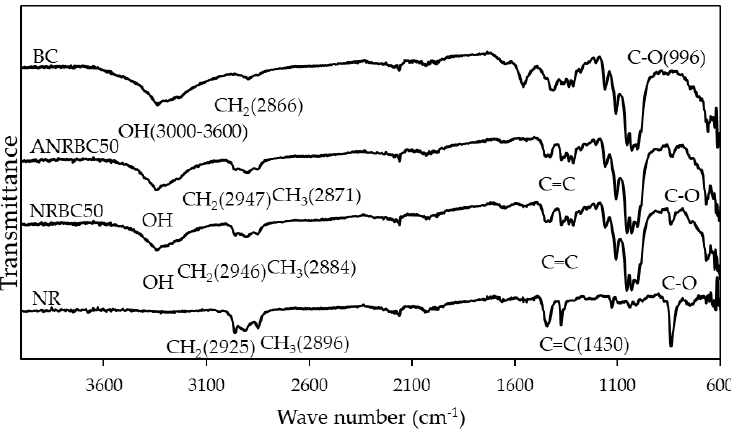
Figure 3. FTIR spectra of NR, BC, NRBC, and ANRBC films.